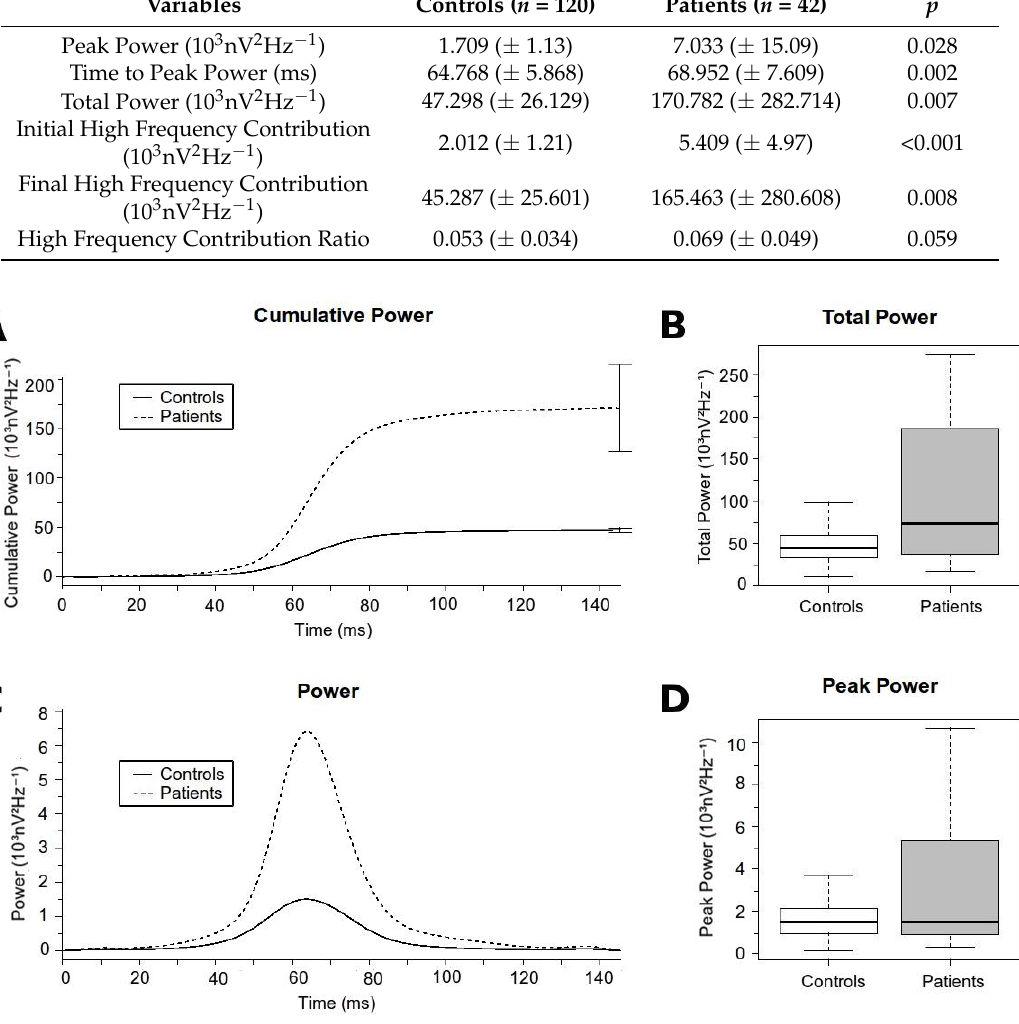
Figure 4. High-frequency content along the QRS Complex. ( A ) Cumulative high-frequency content for each group at each time epoch. The final error bars represents the Total Power with its standard error for each group. ( B ) Boxplot comparing the Total Power. ( C ) Time distribution of the high-frequency content for each group at each time epoch. ( D ) Boxplot comparing the Peak Power.